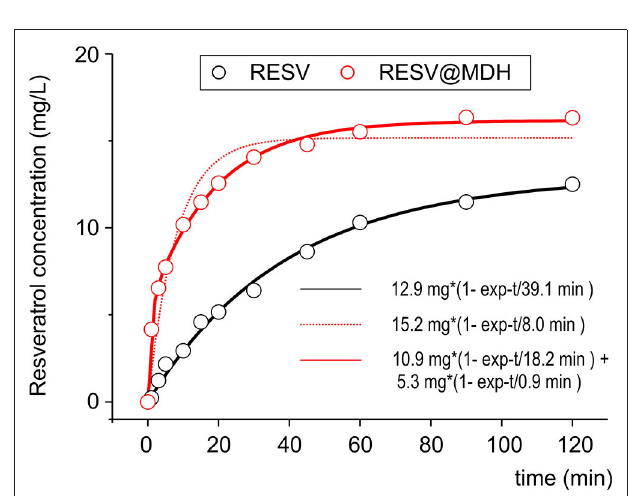
FIGURE 2 | Dissolution profile of resveratrol and Resv@MDH in gastric simulation fluid. The plot reports the solute concentration in mg/L vs. time in minutes. Red dots and black dots indicate the experimental data of Resv@MDH and resveratrol, respectively. The solid red line, black line and red dash line represent the best fits with monoexponential models (black and red dots) and biexponential (red line), respectively, as described in the text.